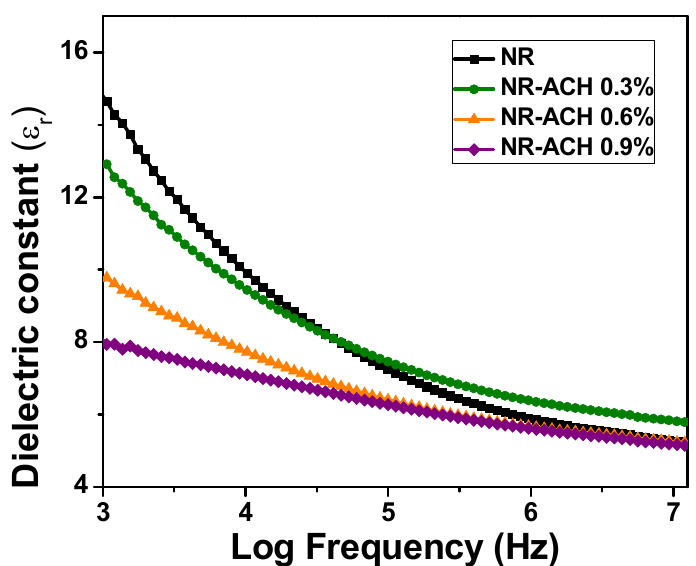
Figure 4. Dielectric constant of NR and NR-ACH 0.3, 0.6, and 0.9% composite films.